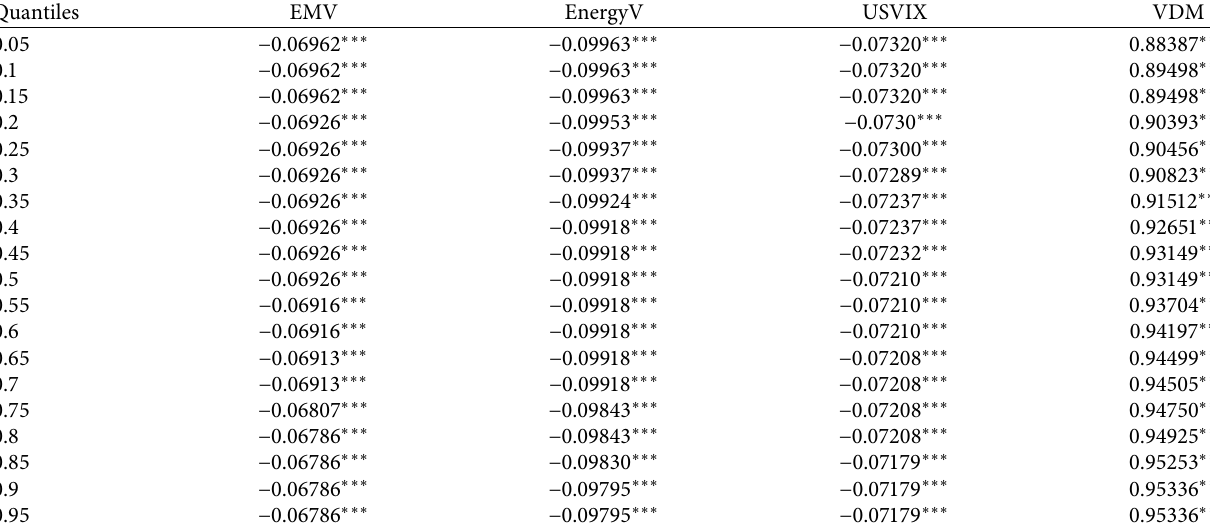
Table 4: Effect of volatilities on